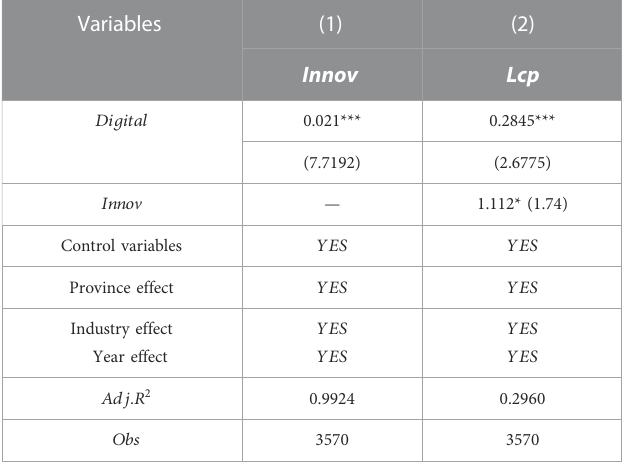
TABLE 9 Results of mechanism